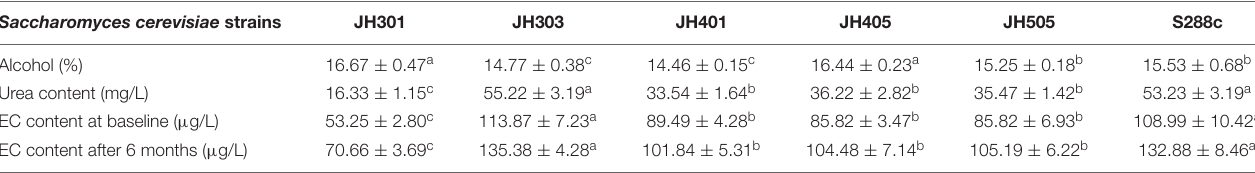
TABLE 3 | Comparison of fermentation quality indexes of different Saccharomyces cerevisiae strains. Saccharomyces cerevisiae